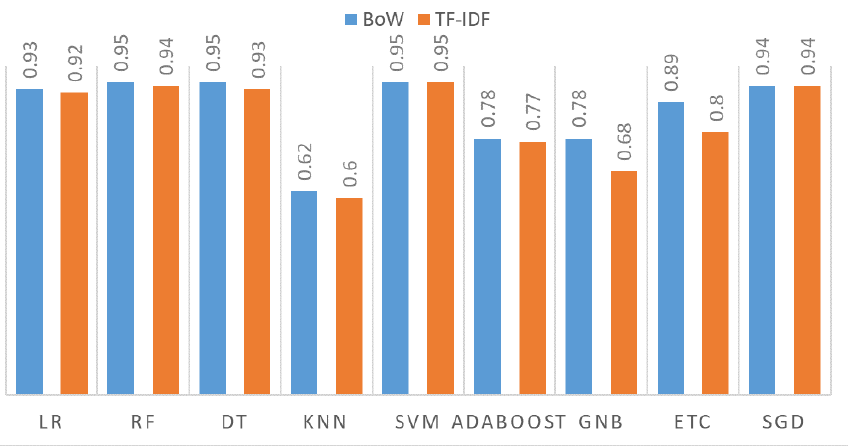
Figure 4. Models’ performance comparison on BoW and TF-IDF features when we used the SMOTE